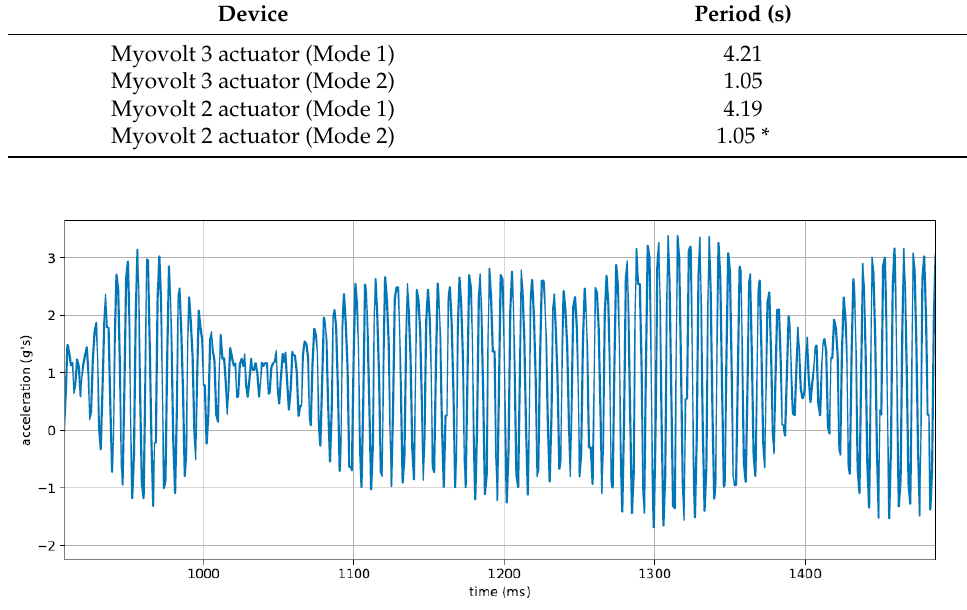
Figure 8. Example of variation in vibration characteristics of the Myovolt multi-actuator vibration devices. These data are from a Myovolt two-actuator in Mode 3 (constant vibration) in the constrained setup. Plot shows the raw accelerometer data along the axis of vibration. Ideally, the peak-to-peak distance should remain